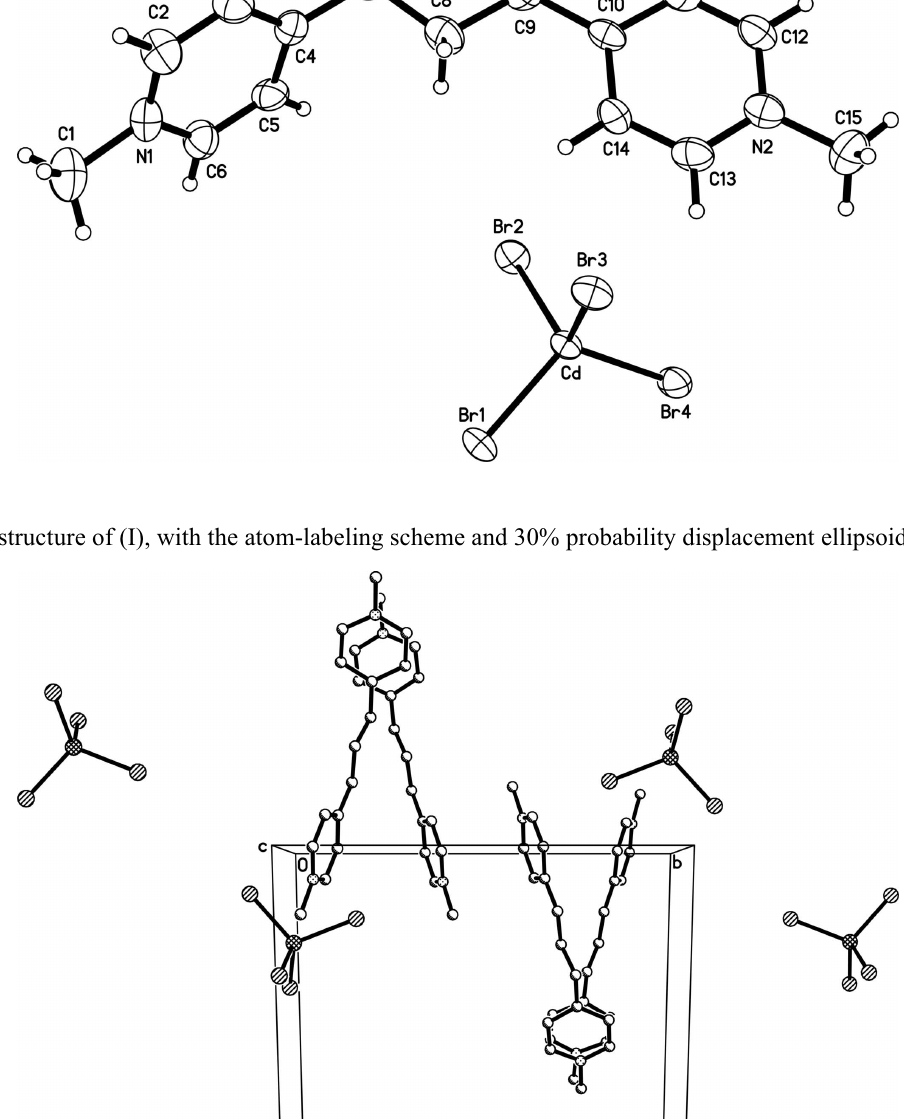
Monoclinic, P 2 Hall symbol: -P